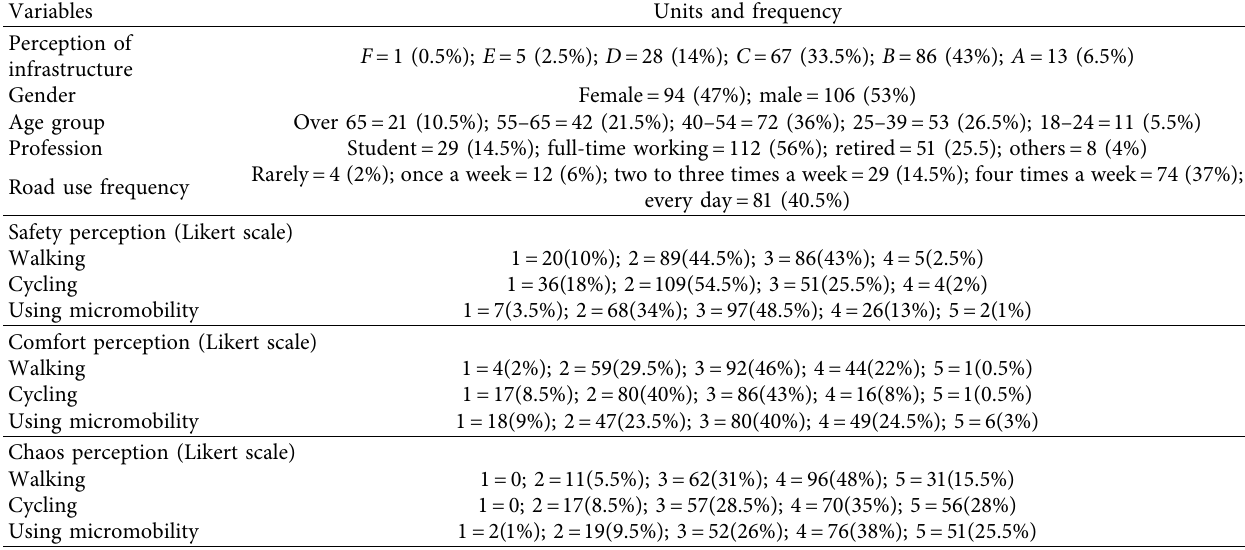
Table 2: Descriptive statistics of variables.